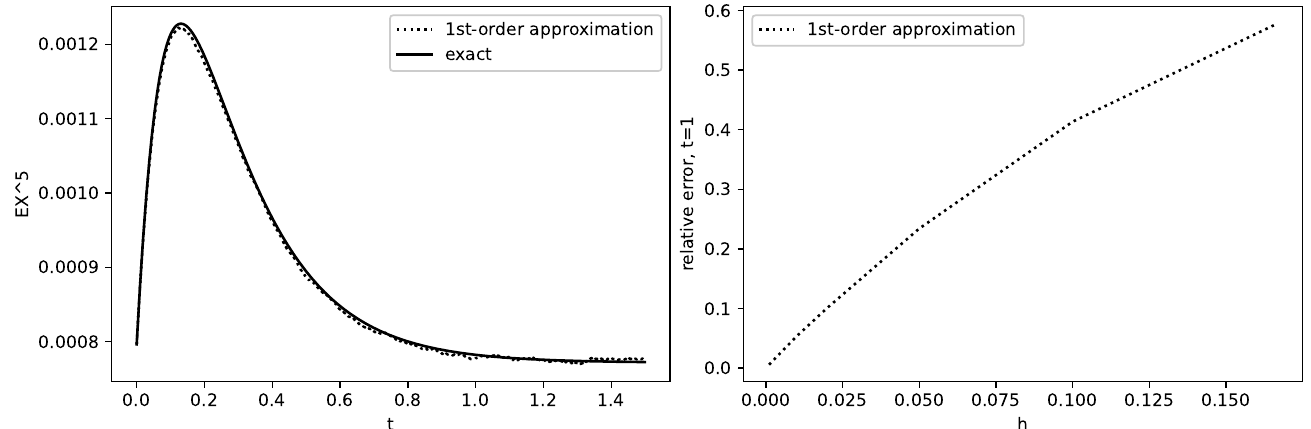
) and E f ( X x ) as functions of t and h for f ( x ) = x 5 : x = 0.24, t t